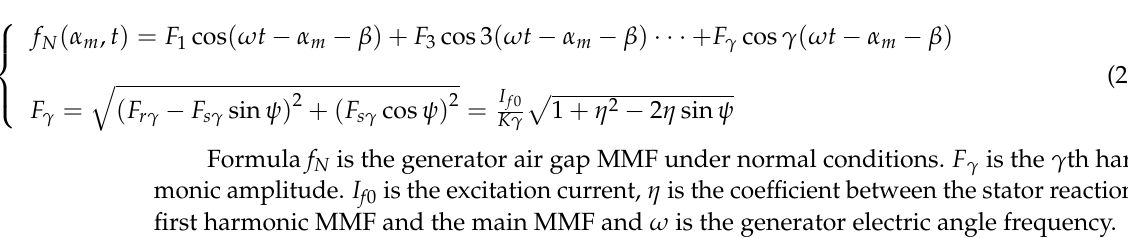
Figure 4. Stator interturn short-circuit model.